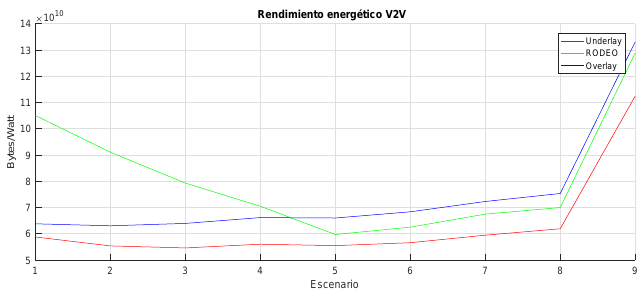
Figure 5. Performance of V2V communications depending on the